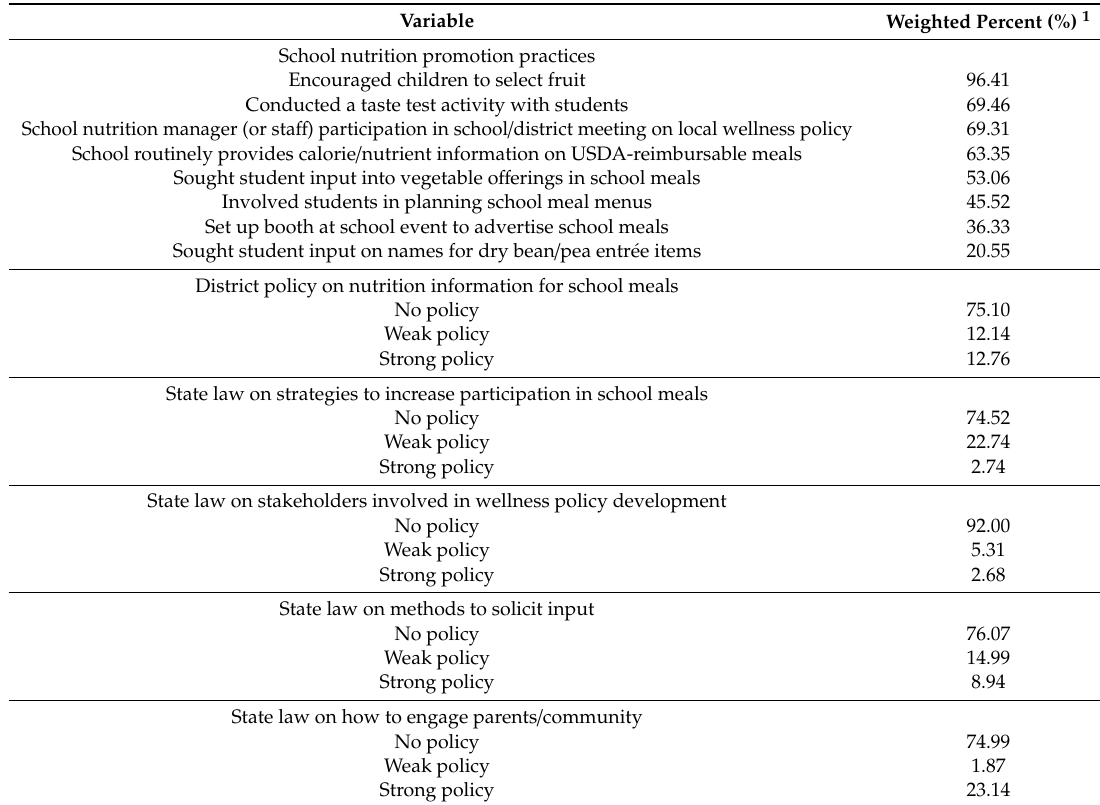
Table 2. Survey-weighted prevalence of school nutrition promotion-related practices and related district policy and state